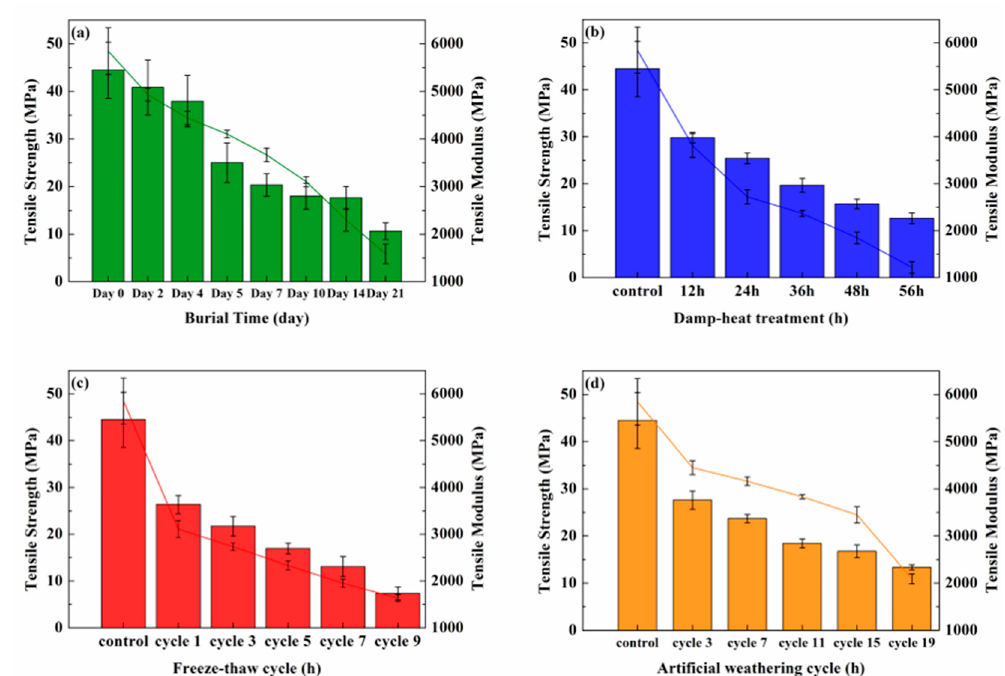
Figure 1. Tensile strength and modulus: ( a ) soil burial degradation; ( b ) damp–heat treatment; ( c ) freeze–thaw cycle; and ( d ) artificial weathering cycle.